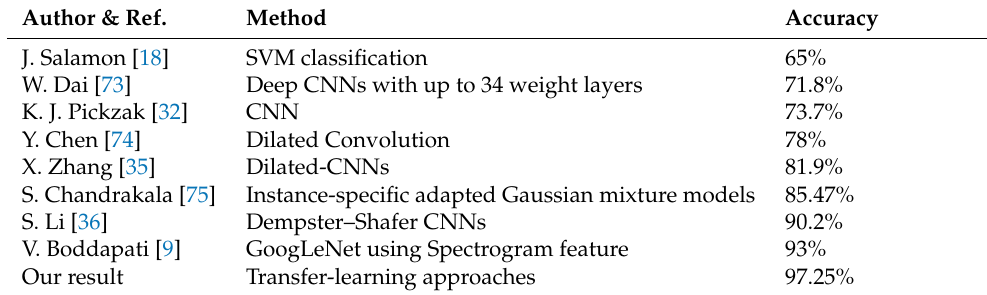
Table 4. Comparison of the previous state-of-the-art and transfer-learning